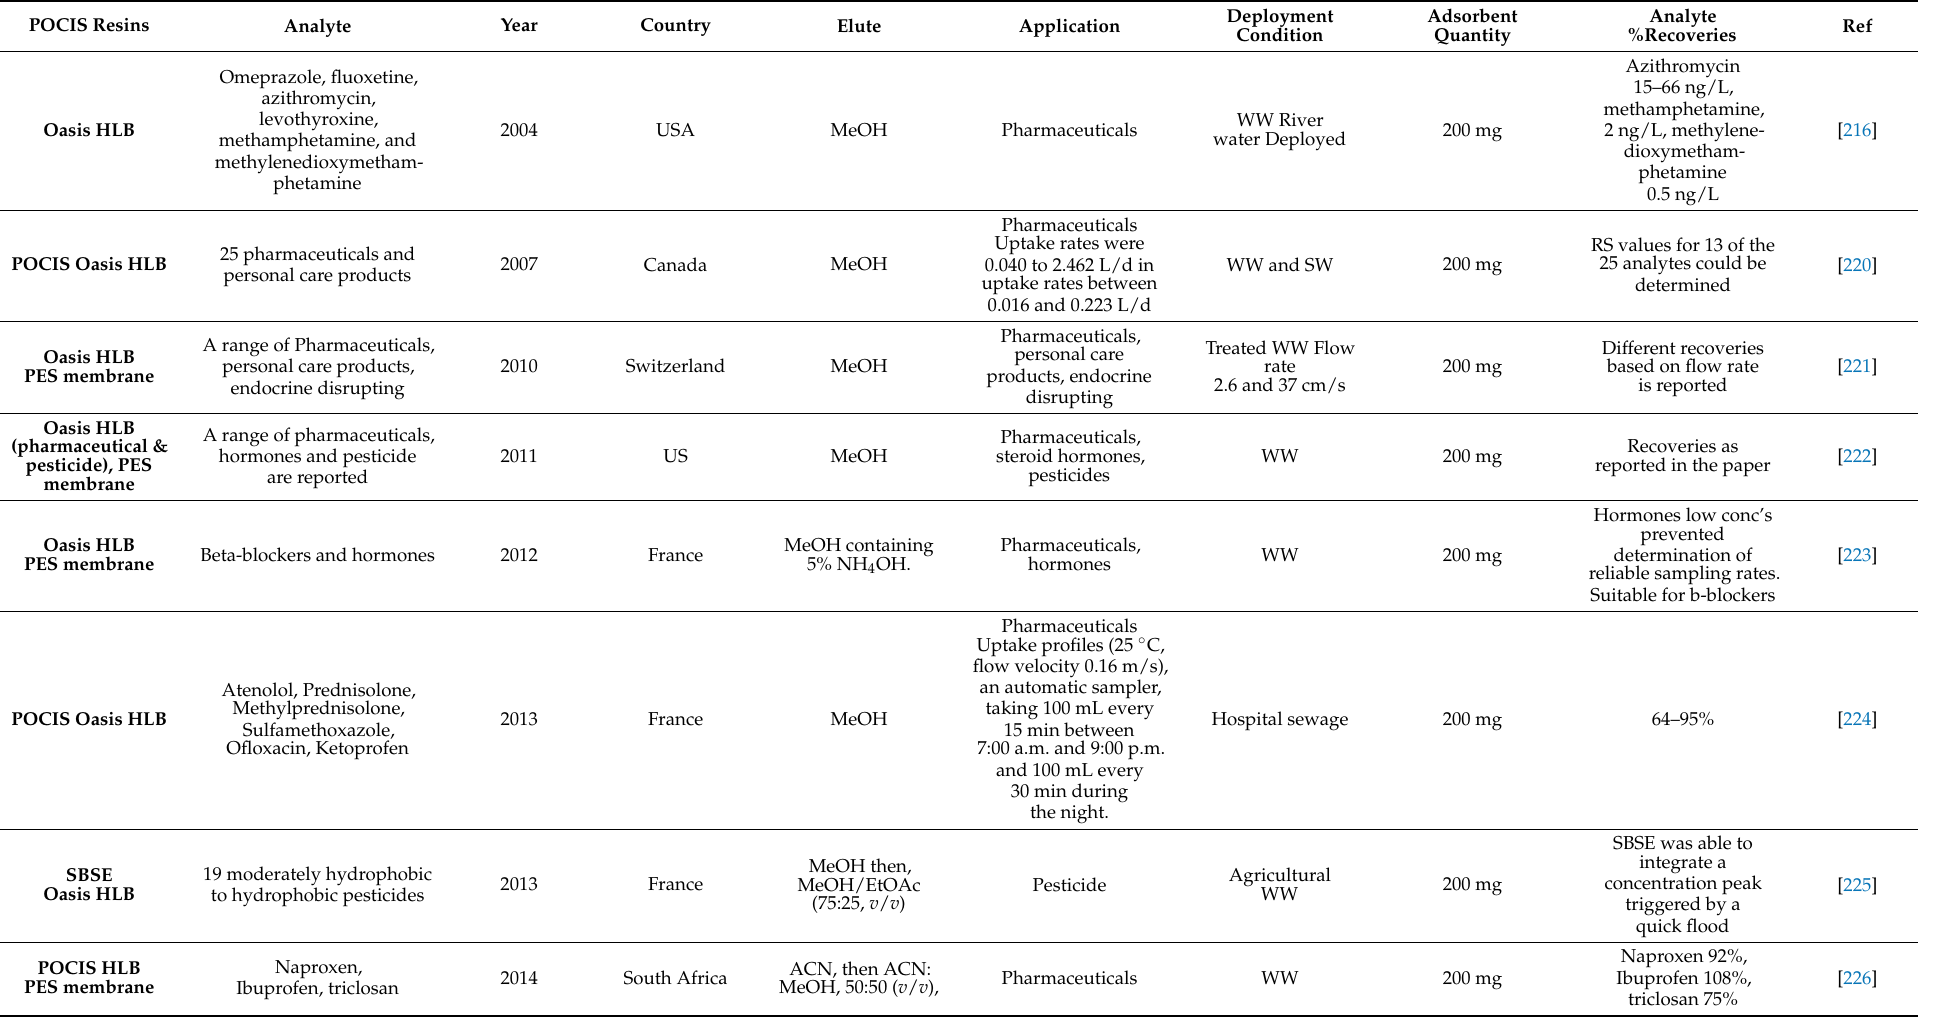
Table 7. Application of POCIS on